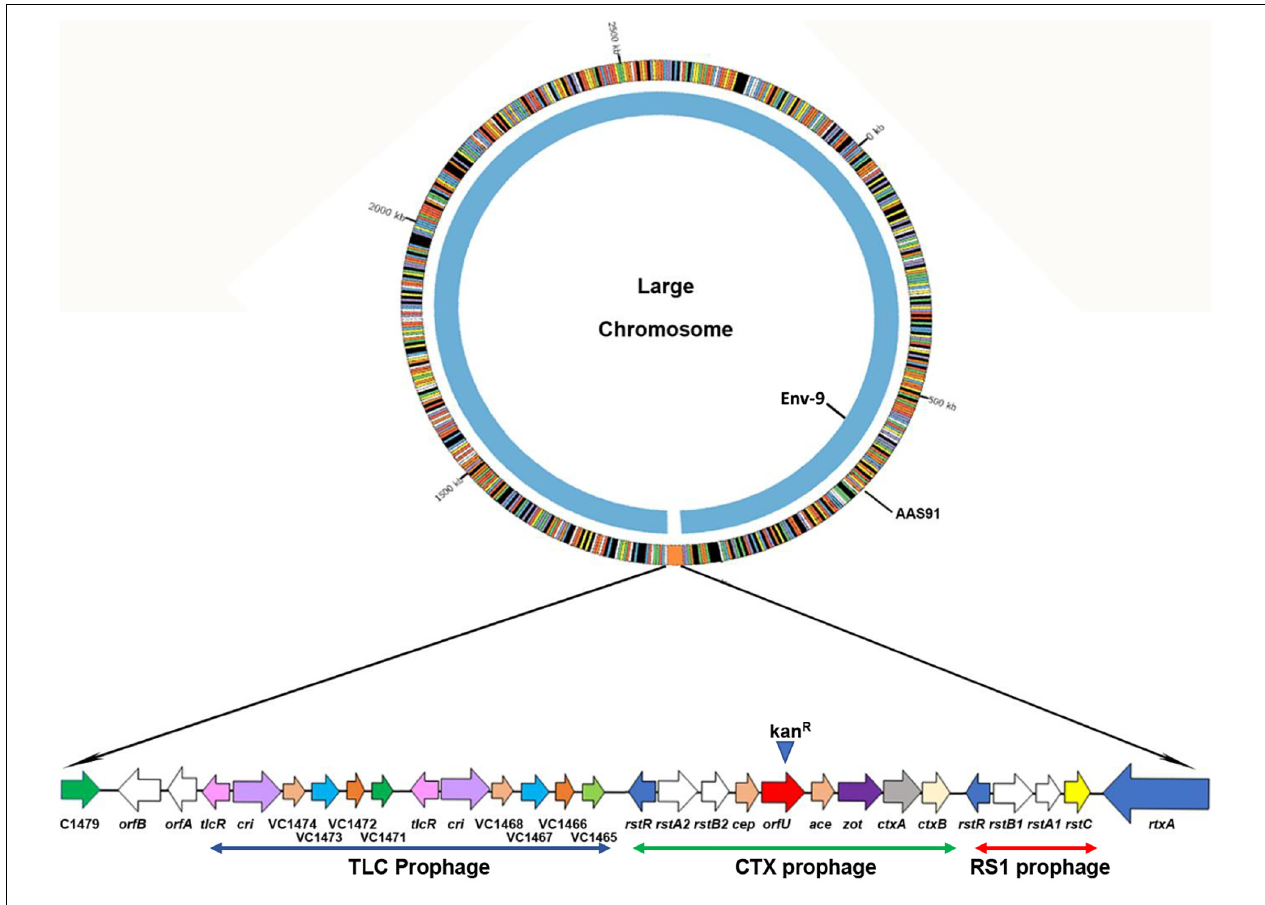
FIGURE 2 | PacBio whole genome sequencing and sequence comparison of Vibrio cholerae AAS91 to that of its mother strain Env-9 (NCBI: NZ_CP012997.1 and NZ_CP012998.1) corroborated the successful integration of the 21,153-bp of RCT prophages between rtxA and VC1479 in AAS91 following chitin-induced transformation. We compared only the large chromosome where RCT is present. While Env-9 lacked RCT prophages (inner chromosome), AAS91 acquired entire RCT prophages as presented in extended form with arrows showing the genes comprising of RCT